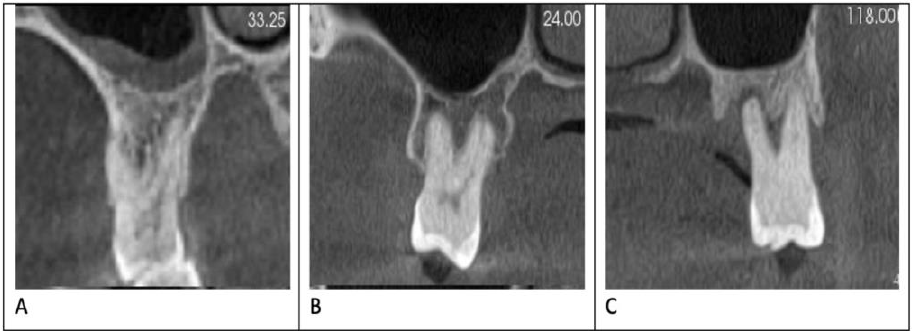
Figure 1. This CBCT cuts demonstrating different degrees of bone loss: ( A ) mild bone loss, ( B ) mod- erate bone loss, and ( C ) severe bone loss.